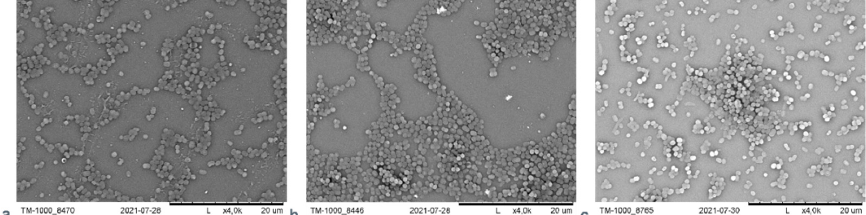
Figure 6. T he SEM visualization of nanocomposite material based on polyethyleneimine (PEI) with incorporated AuNPs or AgNPs with A. baumanni after 24-h cultivation. ( a ): PEI—AuNPs membrane; ( b ): PEI—AgNPs membrane; ( c ): Control— A. baumanni after 24 h of cultivation without membrane.